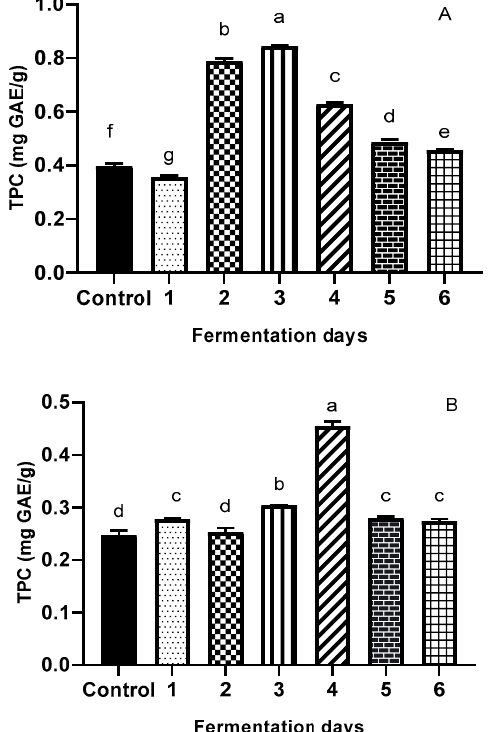
Figure 2. Total phenolic content (Folin–Ciocalteu method) ( A ) illustrating WB; ( B ) illustrating OB of the extracts (control and fermented (6 days)). Total phenolic content of the extracts is expressed as gallic acid equivalents (GAE) in mg / g sample of waste. Values are expressed as mean values ± SD, µ g / g, n = 3, and are followed by di ff erent letters (a–f), indicating significant di ff erences ( p < 0.05) between days of fermentation (One-way ANOVA - Multiple comparison test - Tukey multiple range test ( p = 0.05); GraphPad Prism Version 8.0.1, Graph Pad Software, Inc., San Diego, CA,